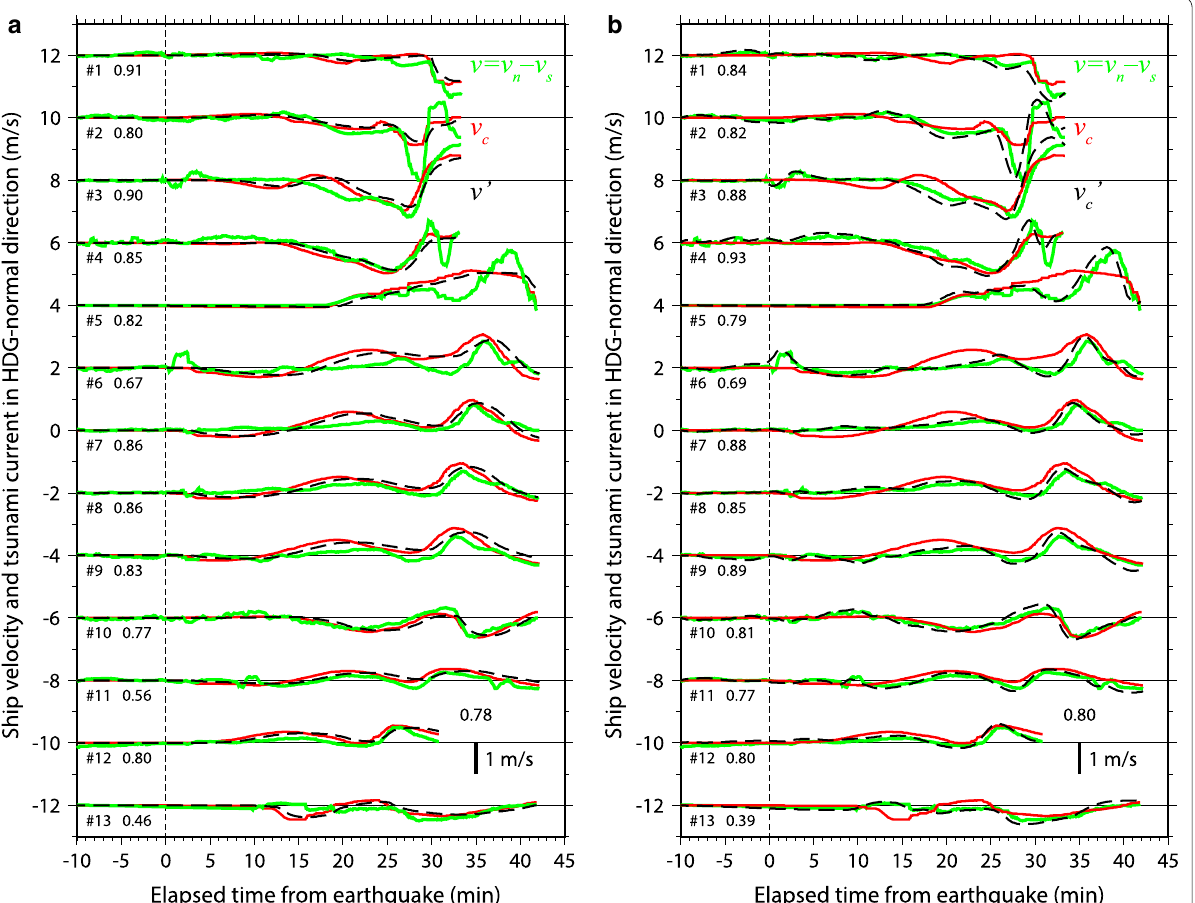
Fig. 8 Ship velocity and tsunami current in the HDG-normal direction. In both a and b , green and red indicate the corrected HDG-normal velocity ( v v n v s ) and the simulated tsunami current ( v c ) shown in Fig. 6b, respectively. Dashed lines indicate ship response ( v ′ ) simulated from v c in ( a ), = − and tsunami current ( v c ′ ) simulated from the ship velocity ( v and between v c and v c ′ in b ,